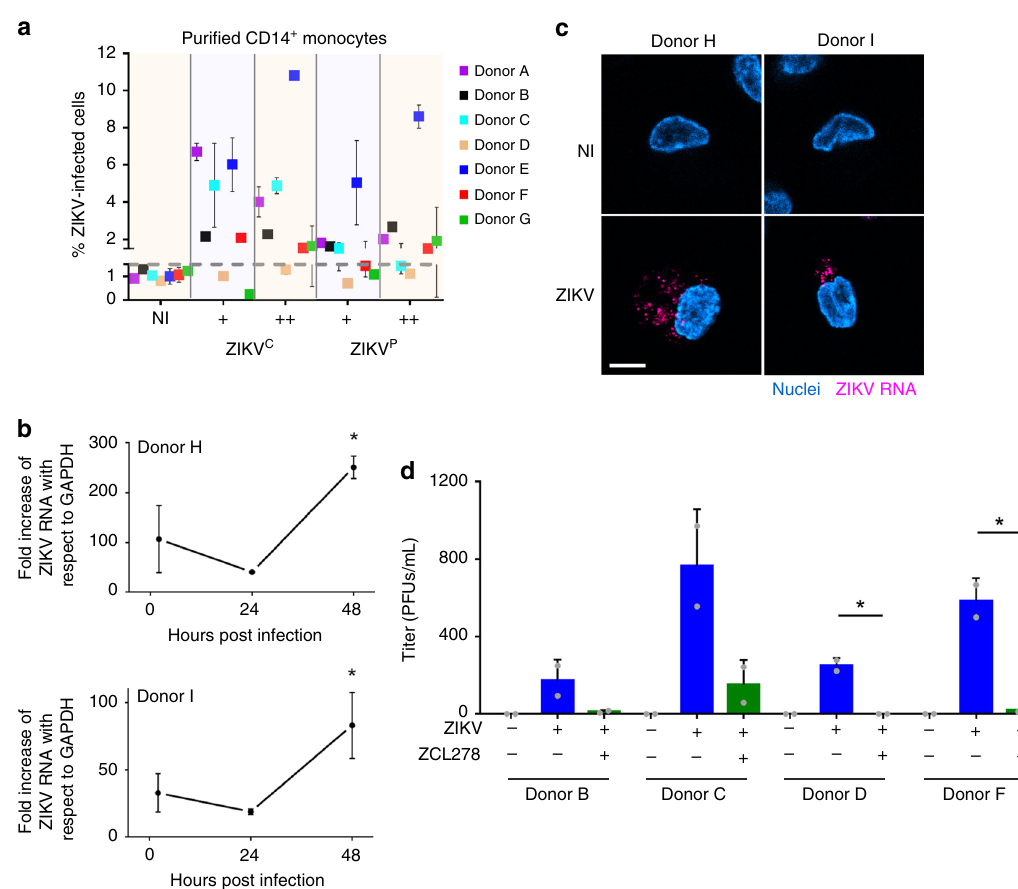
Fig. 2 Human primary monocytes are productively infected by ZIKV. a Monocytes puri fi ed from seven healthy blood donors were infected with Colombian (ZIKV C ) or Panama (ZIKV P ) ZIKV strains at MOI 1 ( + ) or 5 ( ++ ) for 48 h. Cells were fi xed, permeabilized, and processed for fl ow cytometry. The percentage of ZIKV-infected cells (NS2B + ) is plotted as a function of the strain and amount of ZIKV used. Each dot corresponds to the mean ± SD of ZIKV- infected cells for each donor and each condition in two individual samples. b Monocytes were infected for the indicated time with ZIKV (MOI 1) for 48 h. Total RNA was extracted and RT-qPCR was performed by using ZIKV and GAPDH-speci fi c primers. The graph represents the fold change of ZIKV RNA with respect to GAPDH of a triplicate ± SD. Data from two donors are shown. No ZIKV RNA was detected in monocytes from a third donor in this experiment (data provided in the Source Data fi le). c Monocytes infected with ZIKV for 48 h were fi xed and fl uorescence in situ hybridization (FISH) was performed by using a ZIKV-speci fi c RNA probe (magenta) and nuclei were stained with NucBlue (blue). Left and right panels are representative images from experiments done with two donors. Scale bar: 5 µ m. d Monocytes puri fi ed from four healthy donors were untreated or pretreated with 50 µ M ZCL278 for 30 min at 37 °C. The cells were then infected with ZIKV (MOI 1) in the presence or absence of ZCL278. The inoculum was removed at 4 h post infection, after which the cells were washed and re-incubated in complete media for 48 h. The supernatant was harvested and a plaque assay on Vero cells was performed to titrate ZIKV production. The bar graphs represent the mean + SD of two independent samples. Each dot represents the mean of a duplicate. ZCL278 treatment inhibited ZIKV infection of monocytes by 93% (±7). The letters attributed to each donor correlate with the ones in a . The two-tailed p value was <0.05 (*). Statistical signi fi cance was determined by using a t test. NI noninfected. Source data in a – d are provided as a